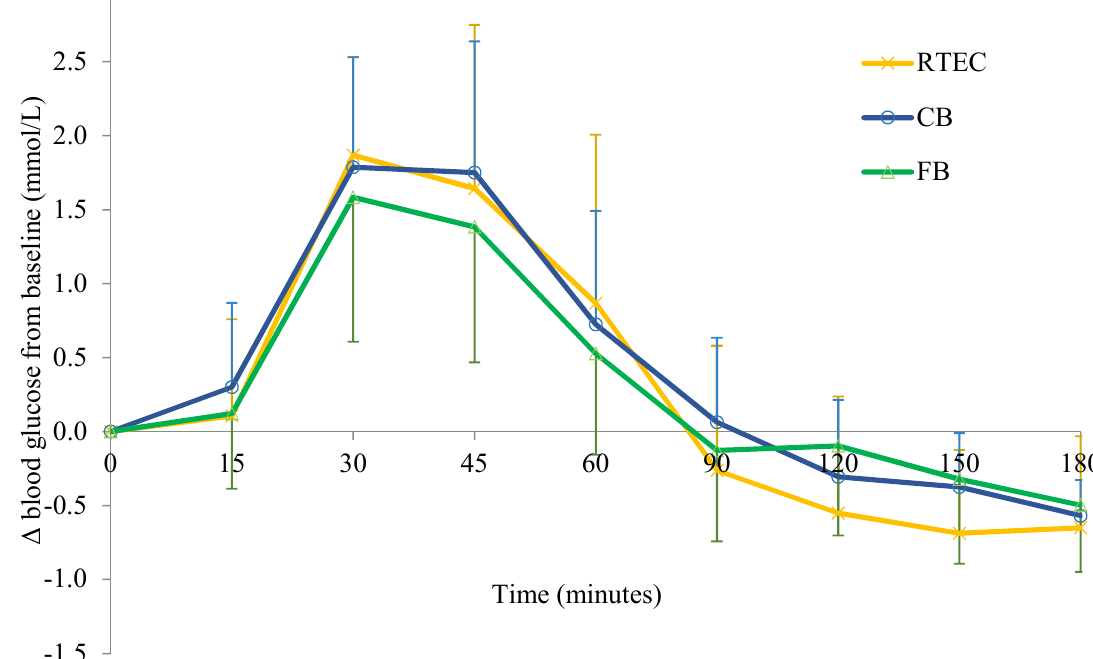
Figure 3. Change from baseline in glucose response (GR) in n = 16 adults following consumption of CB (control breakfast), FB (functional breakfast) and RTEC (ready to eat breakfast cereal). Values are mean difference ± SD.